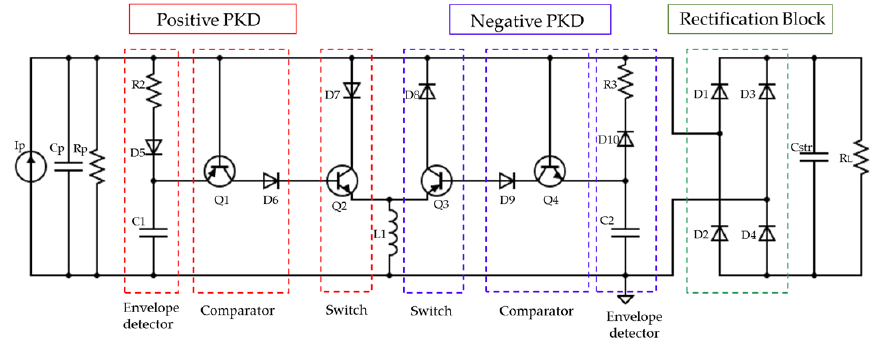
Figure 3. Schematic of the simulation circuit of the state-of-the-art SP-PSSHI referring to [30]. To overcome this limitation, a recent scheme, referred to as NVC-PSSHI [34], was introduced for PEH. The interface is mainly composed of a Parallel Synchronized Switch Harvesting on Inductor (P-SSHI) and a Negative Voltage Converter (NVC). In this interface, the switching is a voltage driven-mechanism realized by two MOSFETs. The targeted input parameters included 3 Volts peak to peak (Vpp) to 7 Vpp input voltage, 100 Hz to 500 Hz frequency range, and 5 k Ω to 30 k Ω DC loading conditions. The proposed interface was